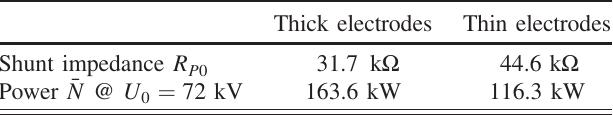
TABLE III. Design parameters of the FNAL